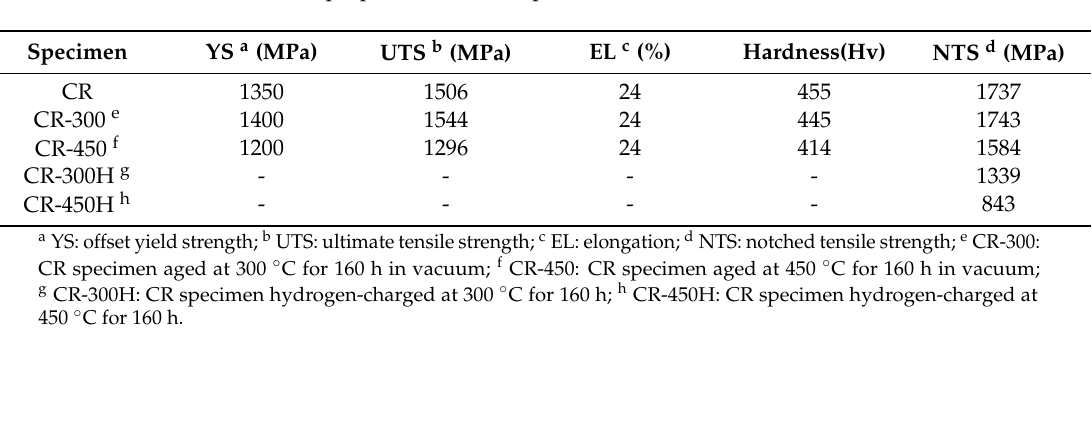
Table 1. Mechanical properties of tested specimens with 30% reduction in thickness.